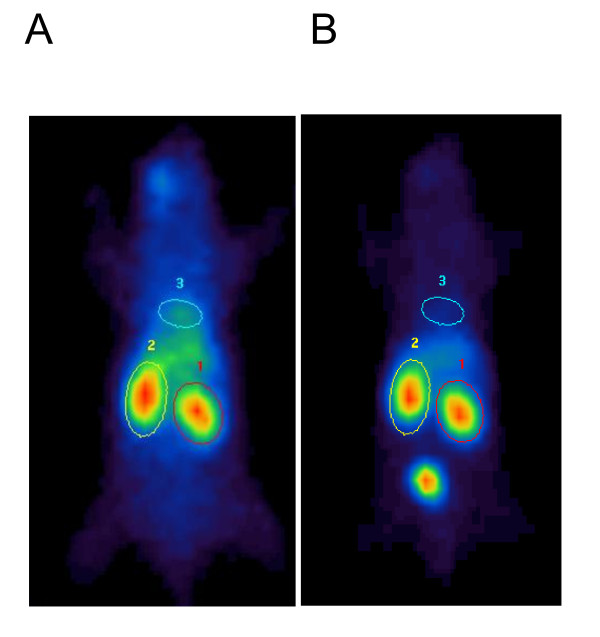
Image files. (A) Data summed between 30 and 90 s post injection. (B) Data summed between 5 and 6 min post injection. The standard manual ROI determination was performed for the left (ROI 1) and right kidneys (ROI 2), the cardiac region including the left ventricle (ROI 3), as well as subrenal kidney backgrounds (not shown).